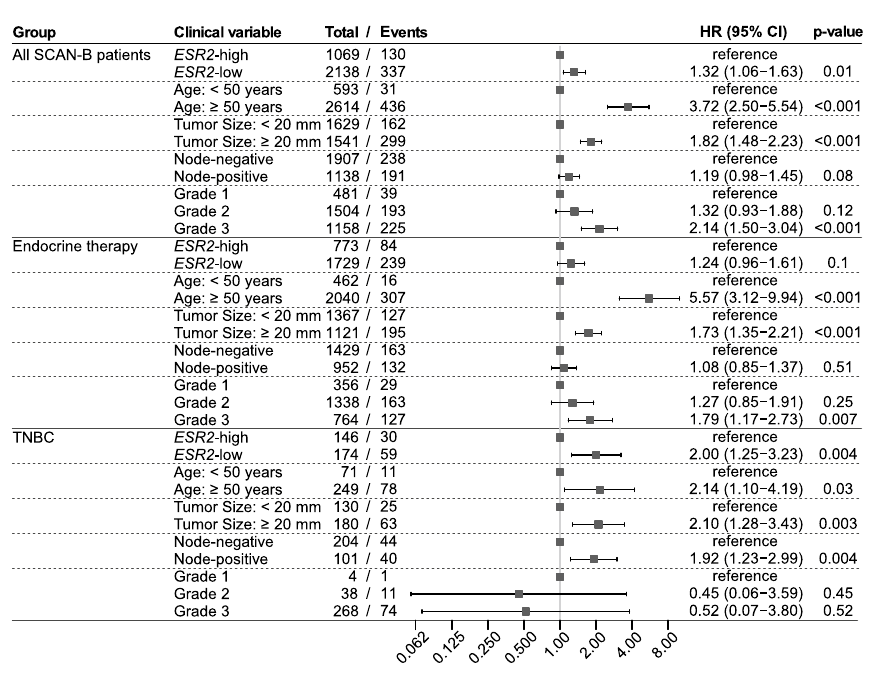
Figure 5. Multivariate analysis of high ESR2 expression in the full SCAN-B cohort, the endocrine-treated group, and the triple-negative breast cancer (TNBC)